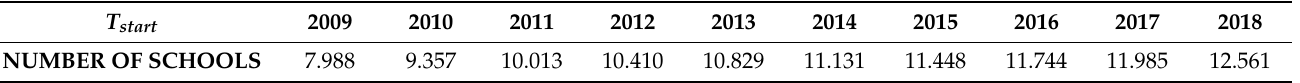
Table 2. Number of schools present in each time